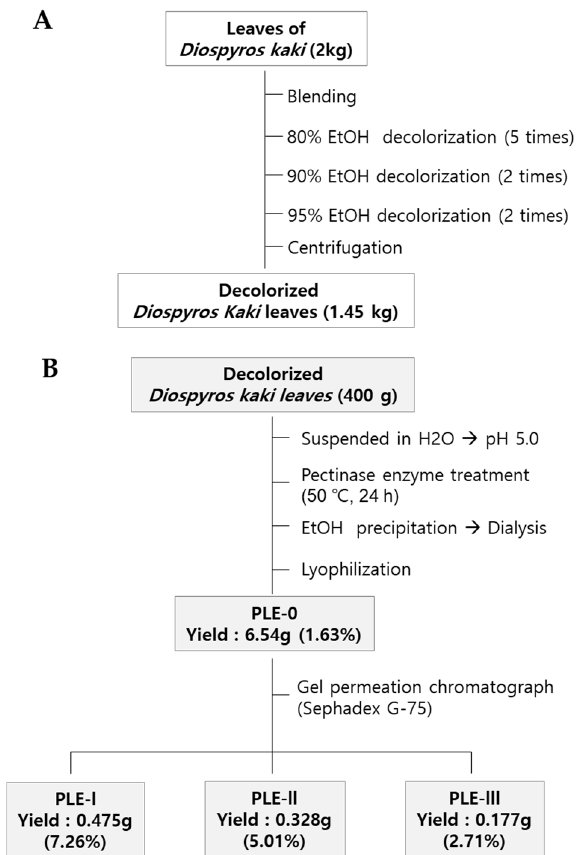
charide ( B ) from persimmon